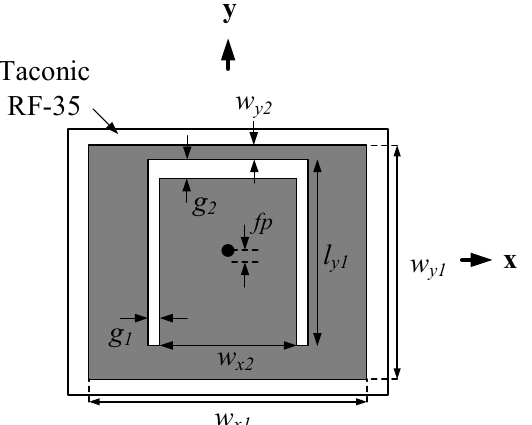
Figure 5. The U-slot microstrip patch antenna used as a source antenna. The design parameters are w x1 = 30 mm, w x2 = 15 mm, w y1 = 25.5 mm, w y2 = 1 mm, l y1 = 20 mm, g 1 = 1 mm, g 2 = 2 mm, and fp = 3 mm.